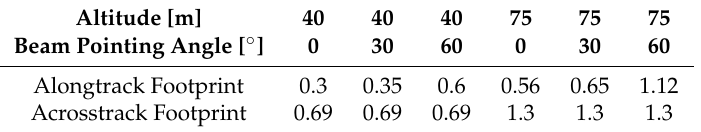
Table 16. Along and Across track resolutions for EM 2040 at 40 and 75 m altitudes, respectively.